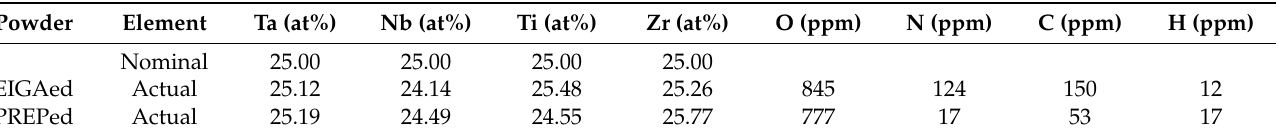
Table 1. Chemical composition of the EIGAed and PREPed TaNbTiZr RHEA powders.